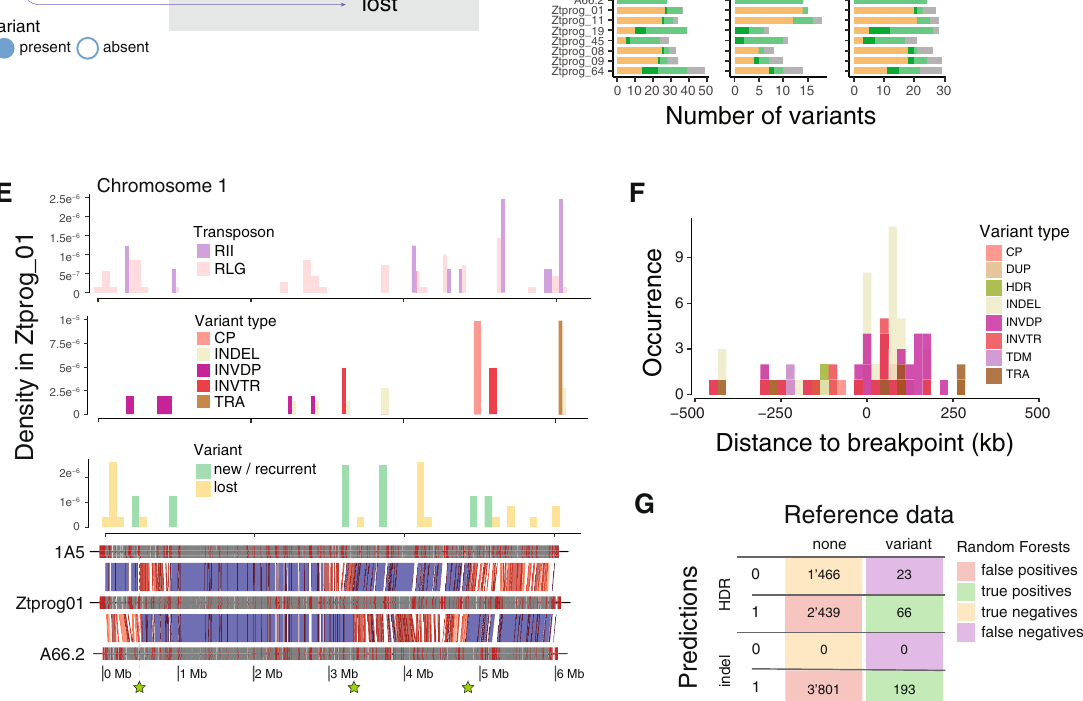
compared to true positives (Wilcoxon rank-sum test, p -value < 0.0001). Consistent with this, we fi nd that the model predicts less false positive within 5 kb of crossover events except for indels and highly diverged regions. In addition, the ratio of false and true discovery rates among progeny is independent of the round of meiosis in the pedigree (Supplementary Fig. 14). In general, model performance is lowest for the second round of meiosis